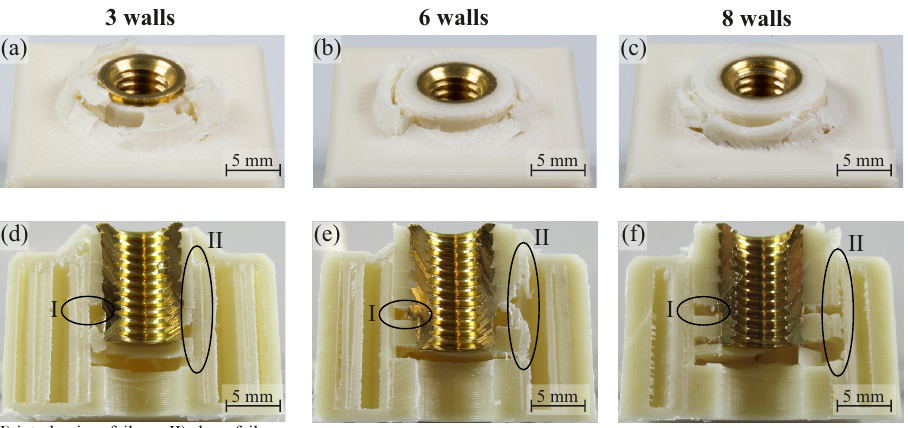
Figure 11. Exemplary test specimens of the test series with varying wall thickness and corresponding sectional views: top view ( a – c ) and sectional view ( d – f ).